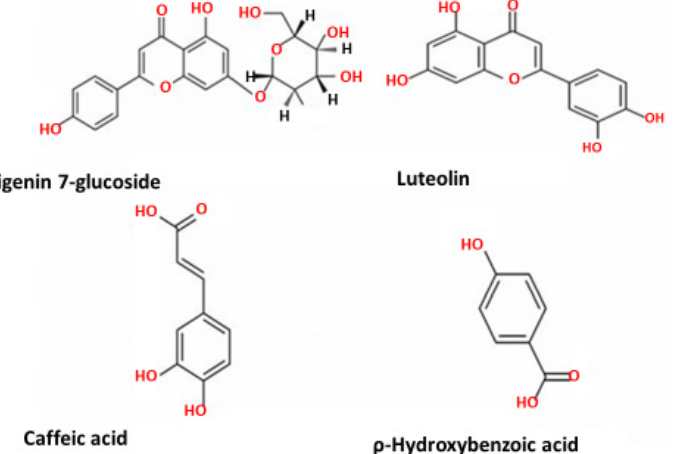
Figure 5. Chemical structures of the predominant phenolic compounds in cold-pressed macadamia nut oil.